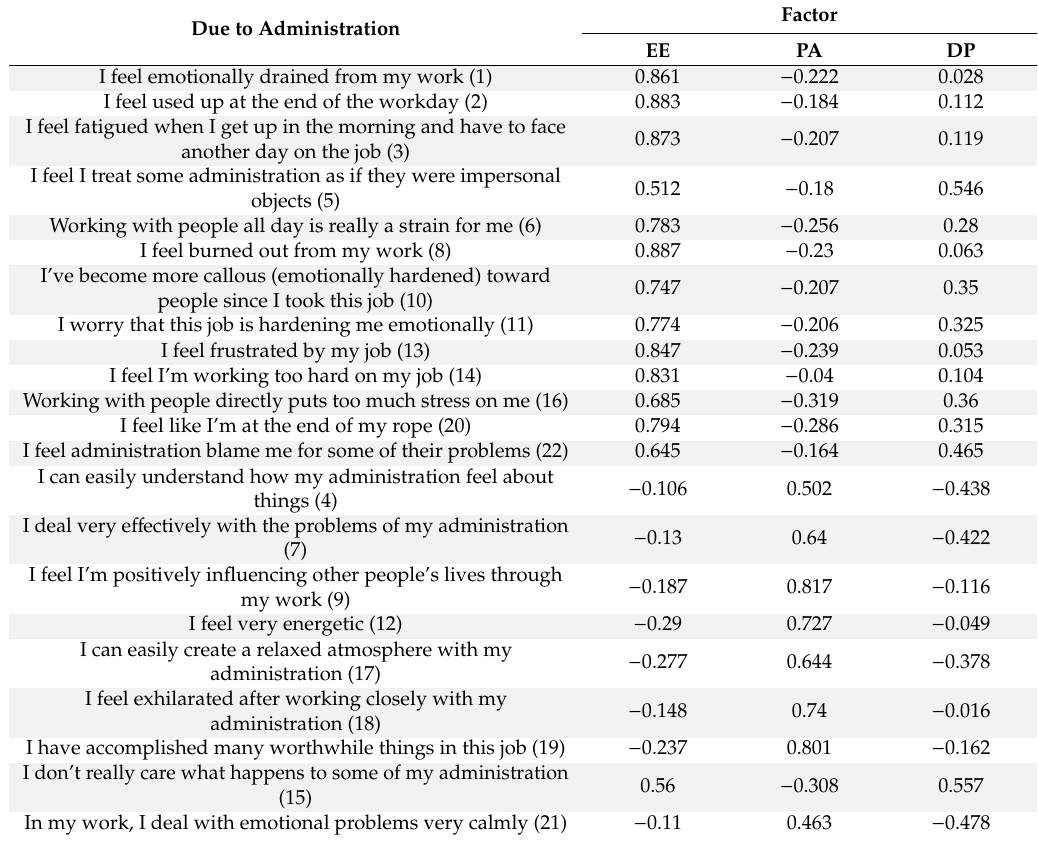
Table A3. Rotated Factor Matrix for Burnout due to